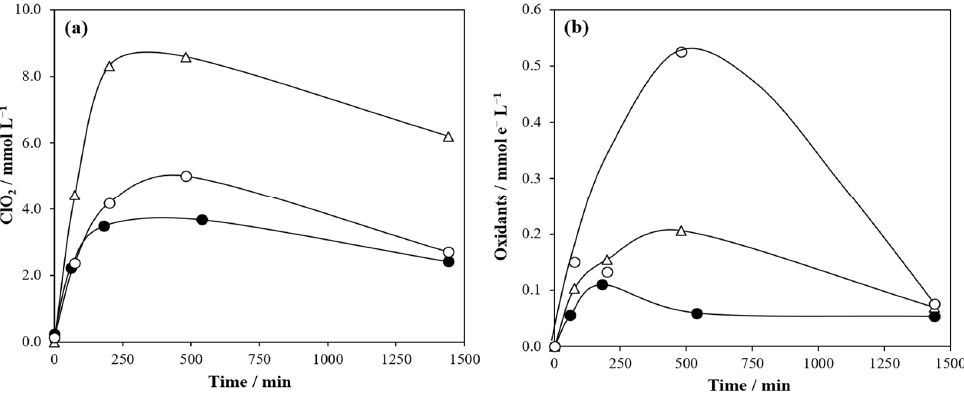
Figure 4. Chlorine dioxide concentration produced in the liquid reaction mixture ( a ) and oxidants in the gas phase ( b ) with different ratios of hydrogen peroxide/chlorate at 60 °C. Legend: ( ● ) ratio H 2 O 2 /ClO 3 − = 0.2, ( ∆ ) ratio H 2 O 2 /ClO 3 − = 1.0 and ( ○ ) ratio H 2 O 2 /ClO 3 − =